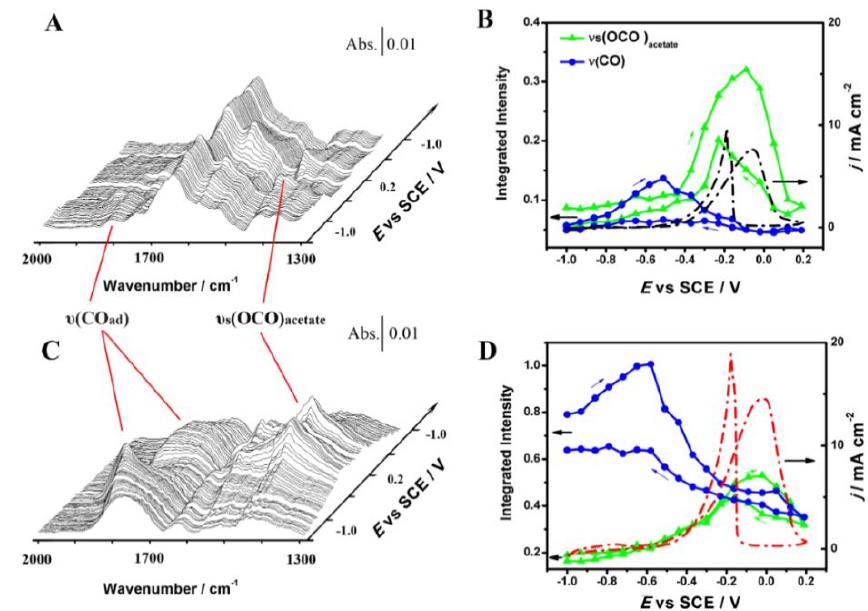
Figure 13. Potentiodynamic ATR-SEIRAS spectra on the as-deposited Pd–Ni–P film ( A ) and the de-alloyed film ( C ) in 0.1 M NaOH + 0.5 M ethanol; Potential-dependent band intensities for ν(CO ad ) (blue) and ν s(OCO) of adsorbed acetate (green) with corresponding CVs recorded at 5 mV·s −1 on the as-deposited Pd–Ni–P film ( B ) and the de-alloyed film ( D ) in 0.1 M NaOH + 0.5 M ethanol. Reproduced with permission from Reference [24]. Copyright 2014,